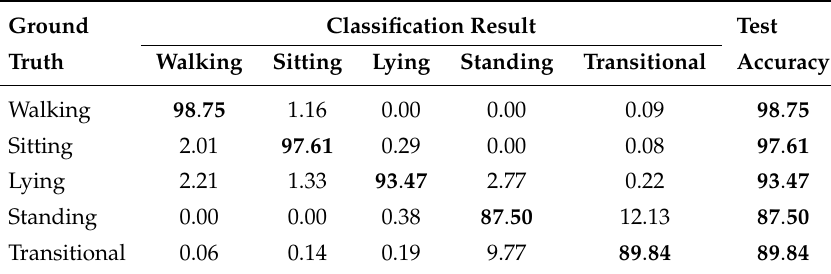
Table 4. Mean accuracy of the second-layer random forest